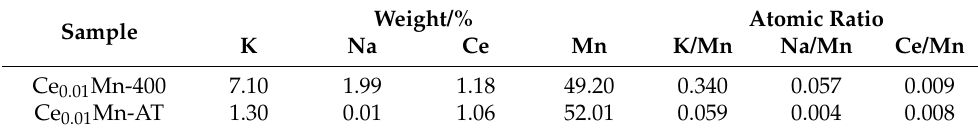
Table 1. Weight composition and atomic ratio for the Ce 0.01 Mn-400 and Ce 0.01 Mn-AT samples.